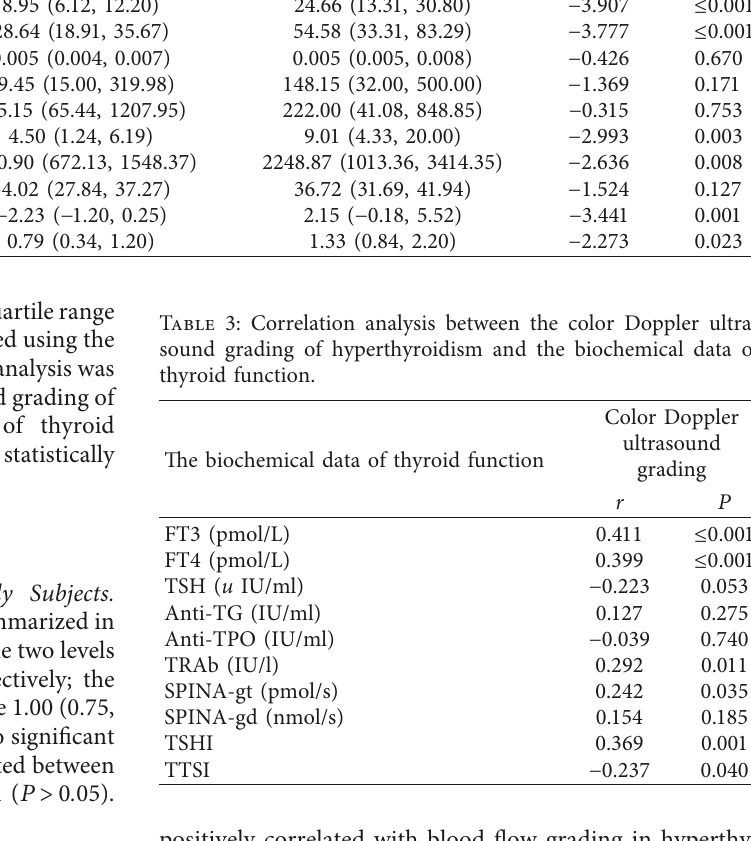
Table 2: Mann–Whitney U test between the color Doppler ultrasound grading of hyperthyroidism and the biochemical data of thyroid function. The biochemical data of thyroid function